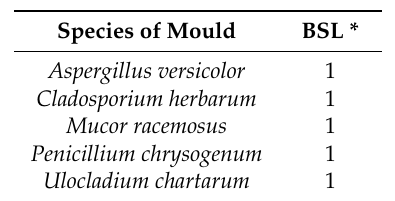
Table 6. Classification of biosafety levels of selected moulds potentially pathogenic for humans and animals